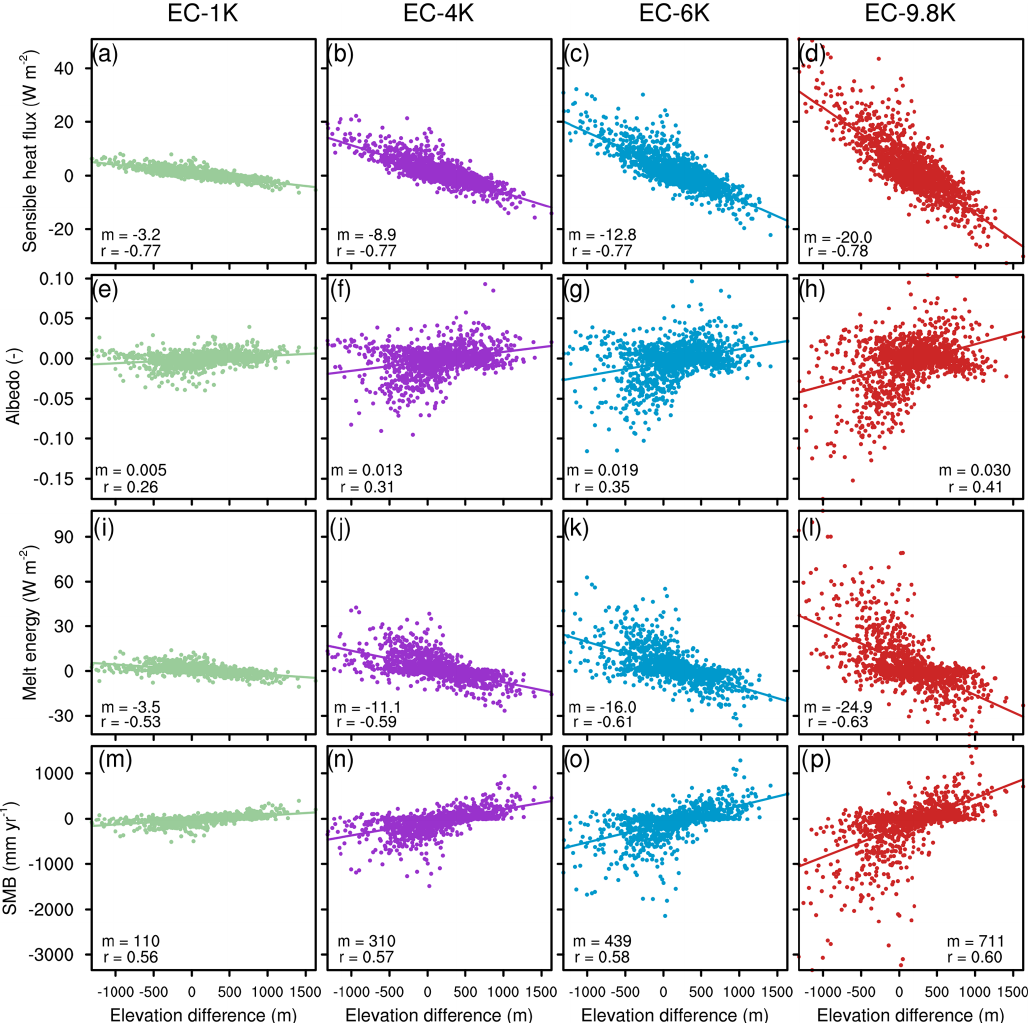
Figure 3. Comparison of 1965–2005 summer (JJA) downscaled energy fluxes among four simulations with different elevation corrections for the atmospheric temperature forcing. The first column corresponds to EC-1K, the second to EC-4K, the third to EC-6K, and the last to EC- 9.8K for (a) – (d) sensible heat flux (Wm − 2 ), (e) – (h) albedo (-), (i) – (l) melt energy (Wm − 2 ), and (m) – (p) surface mass balance (mmyr − 1 ). The x and y values represent the deviation of surface elevation and energy component for each data point with respect to the climate model grid ( ∼ 100km) mean. The lines represent least-squares linear regressions. The annotated m is the least-squares linear regression gradient (Wm − 2 km − 1 or km − 1 for albedo); r is the correlation